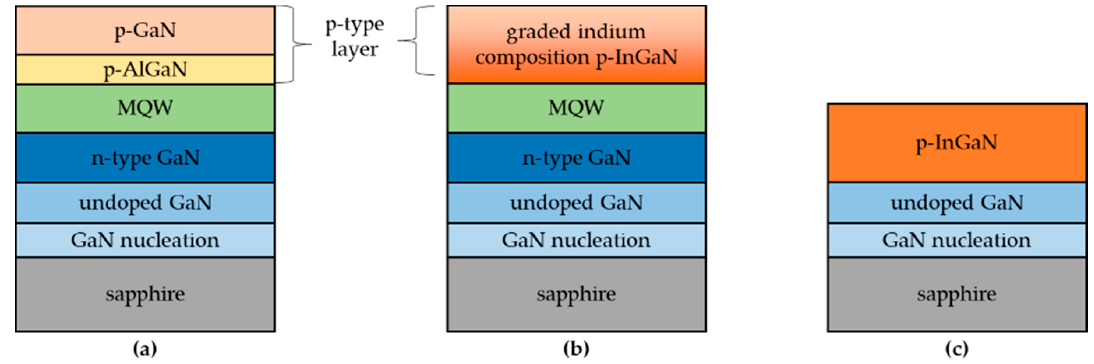
Figure 1. Schematic diagrams for the LED and p-InGaN samples: ( a ) sample A; ( b ) sample B; and ( c ) sample